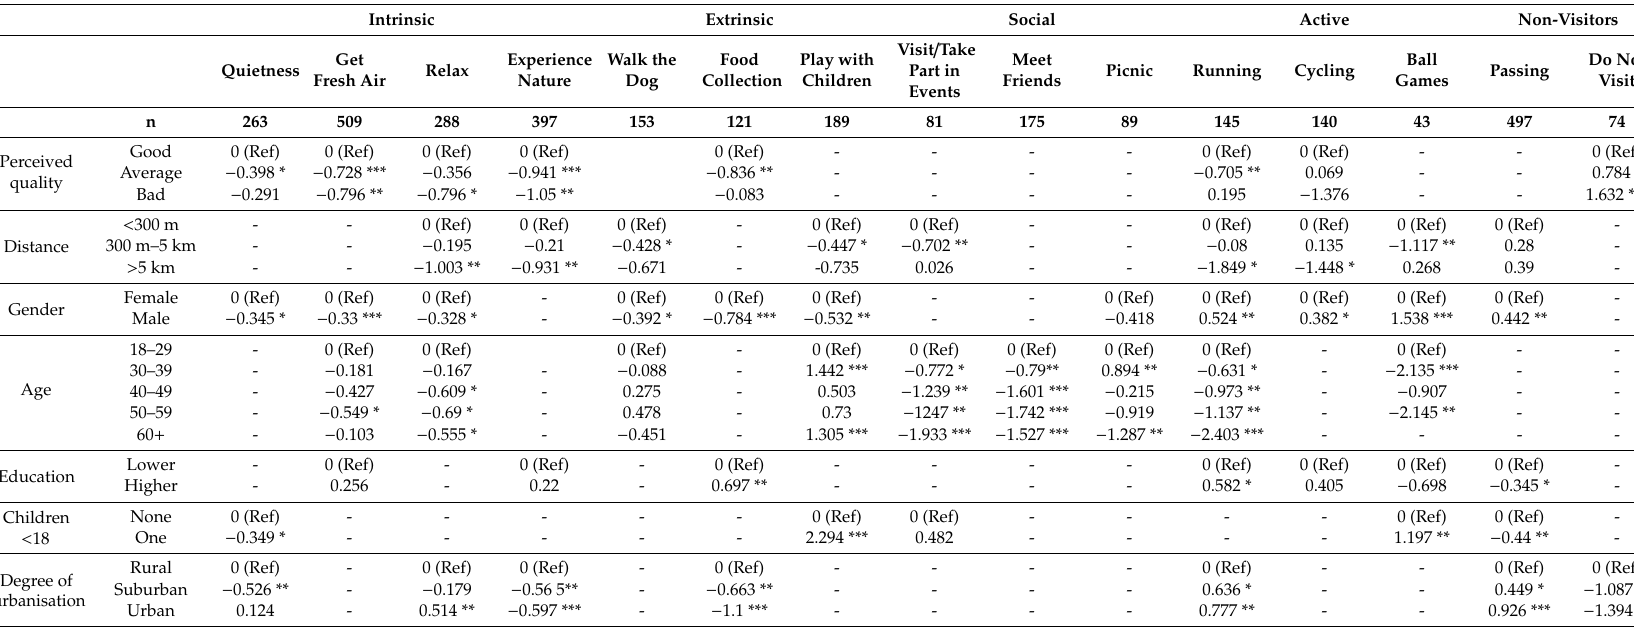
Table 4. Linear regression model outcomes with stepwise backward inclusion of significant predictor variables for activities based on a sample of 1010 adult Norwegians. Presented as slope values and p -value significance levels: 0 ‘***’, 0.001 ‘**’, 0.01 ‘*’,